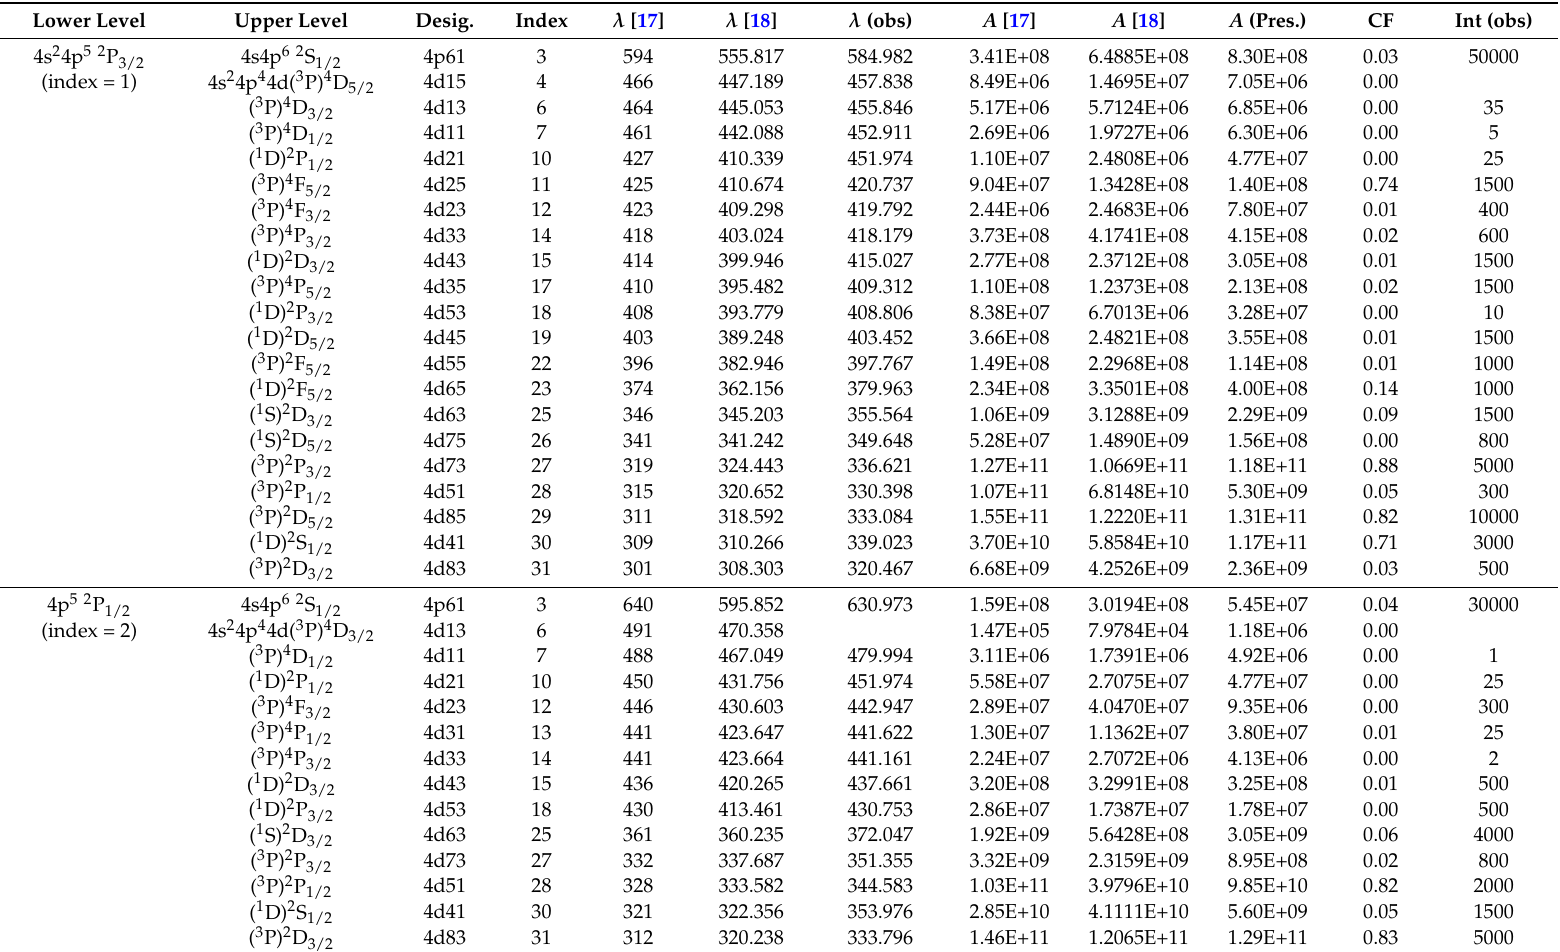
Table 8. Comparison of wavelengths λ (Å) and transition probabilities A (s − 1 ) for Y V calculated with the MCDF2 method of Singh et al. [17] and the GRASP3 method of Aggarwal and Keenan [18] with present values. Index numbers are those used in [17,18]. Blank spaces indicate that line was not observed. Designations are for the upper levels in the